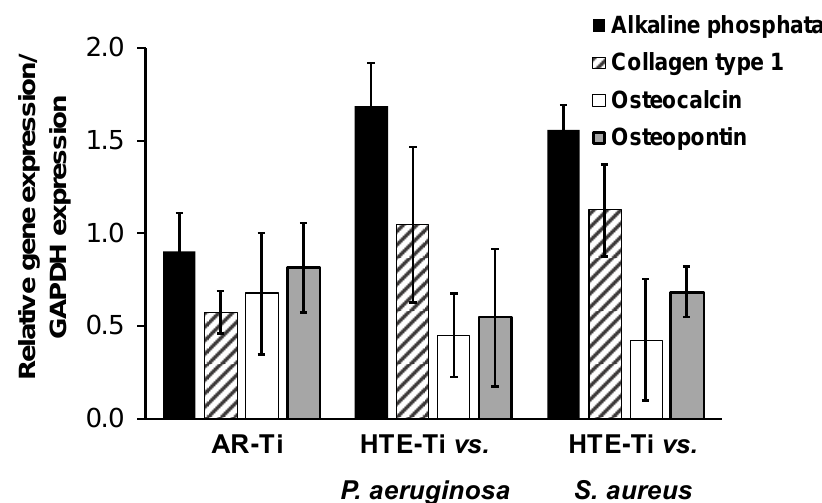
Figure 6. Expression of osteogenesis-related factors in MG-63 cells after 10 days of incubation on the nanostructured surfaces pre-infected with Pseudomonas aeruginosa and Staphylococcus aureus cells. The expressions of alkaline phosphatase—and collagen type 1 (Col 1)—were found to be greater on HTE-Ti surfaces, whereas osteocalcin and osteopontin (OPN) were expressed to a lesser extent on these surfaces. Glyceraldehyde 3-phosphate dehydrogenase (GAPDH) was used as a reference gene to normalize the expression levels.